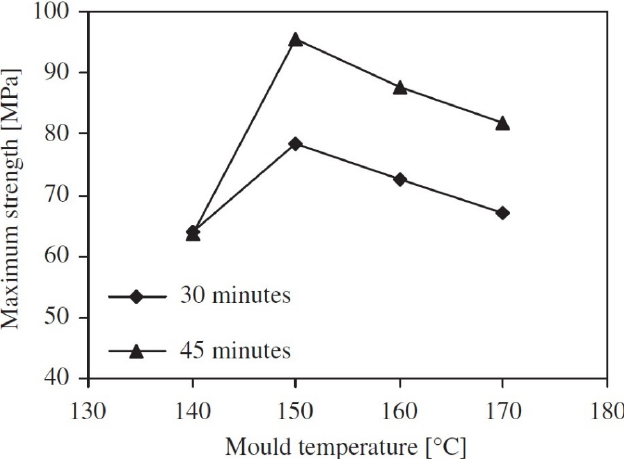
Figure 11. Maximum strength 23 °C for various mold temperatures and for various polymerization times. Dry as-molded properties. Reprinted from Reference [8], under open-access license.